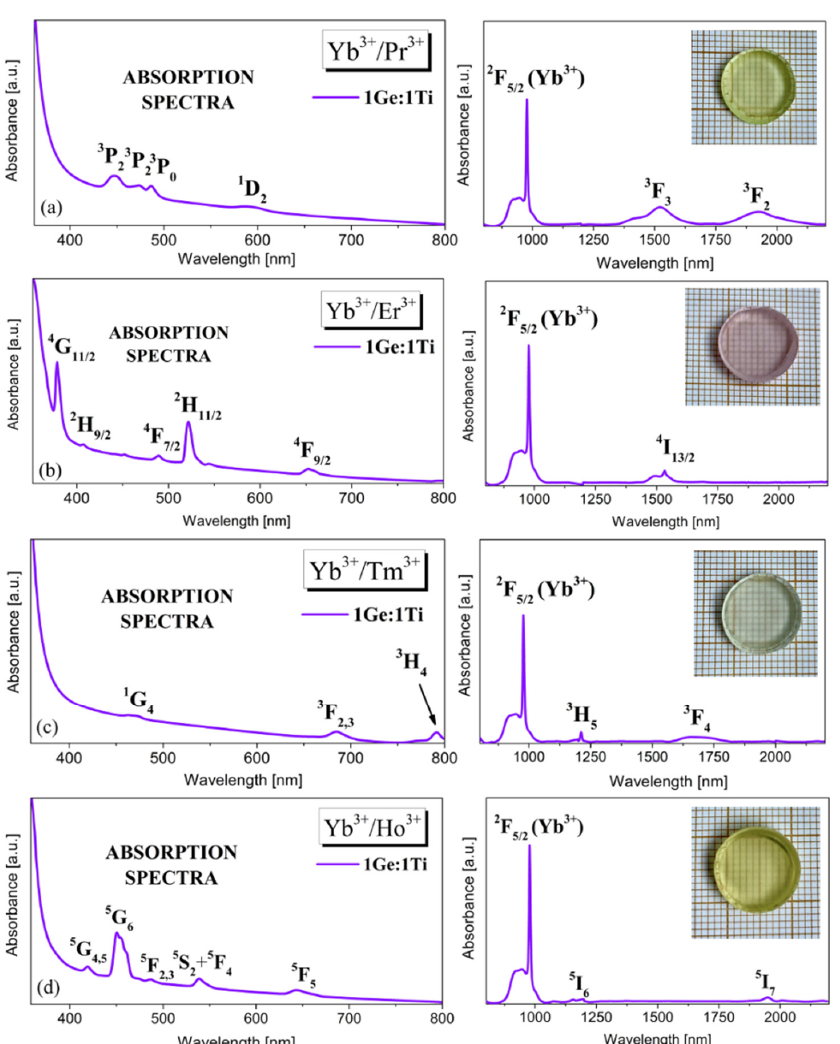
Figure 1. Typical absorption spectra of titanate–germanate glasses co-doped with Yb 3+ /Pr 3+ ( a ), Yb 3+ /Er 3+ ( b ), Yb 3+ /Tm 3+ ( c ) and Yb 3+ /Ho 3+ ( d ). Inset shows a photographic image of the glass sample.